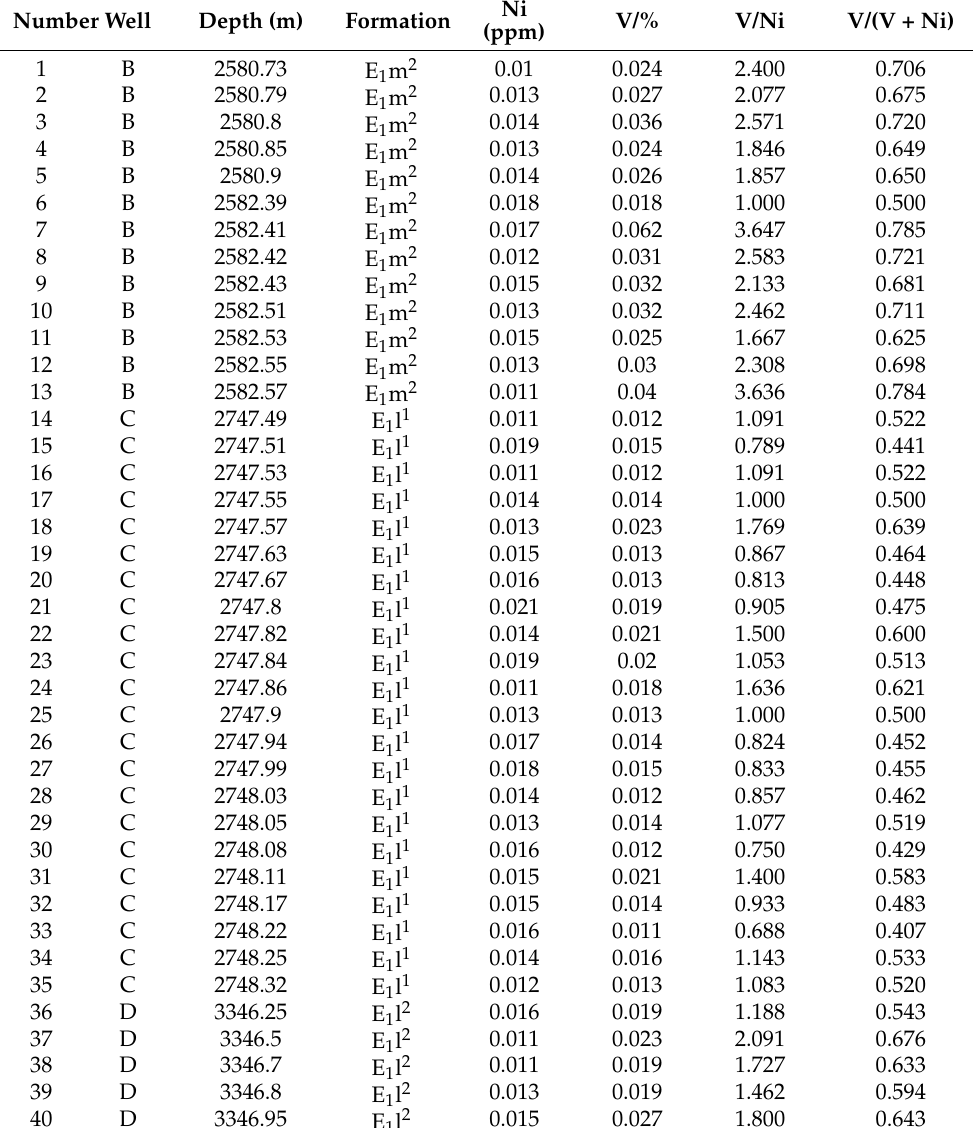
Table 4. The test data of V and Ni in the West Lishui Sag (according to China University of Geosciences). Number Well Depth